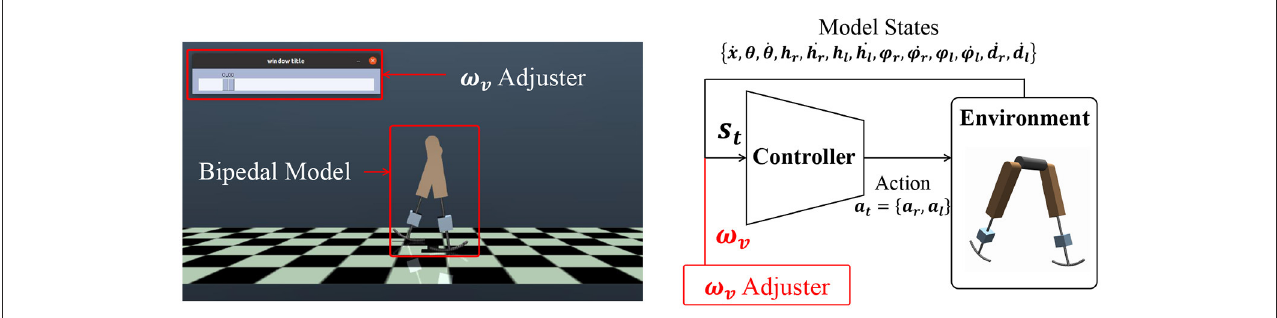
FIGURE2 Bipedal model control in a simulation environment and the basic diagram of the control system. The inputs for the controller include a command ω v . The value of ω v can be changed through the ω v adjuster. s t consists of the model states (